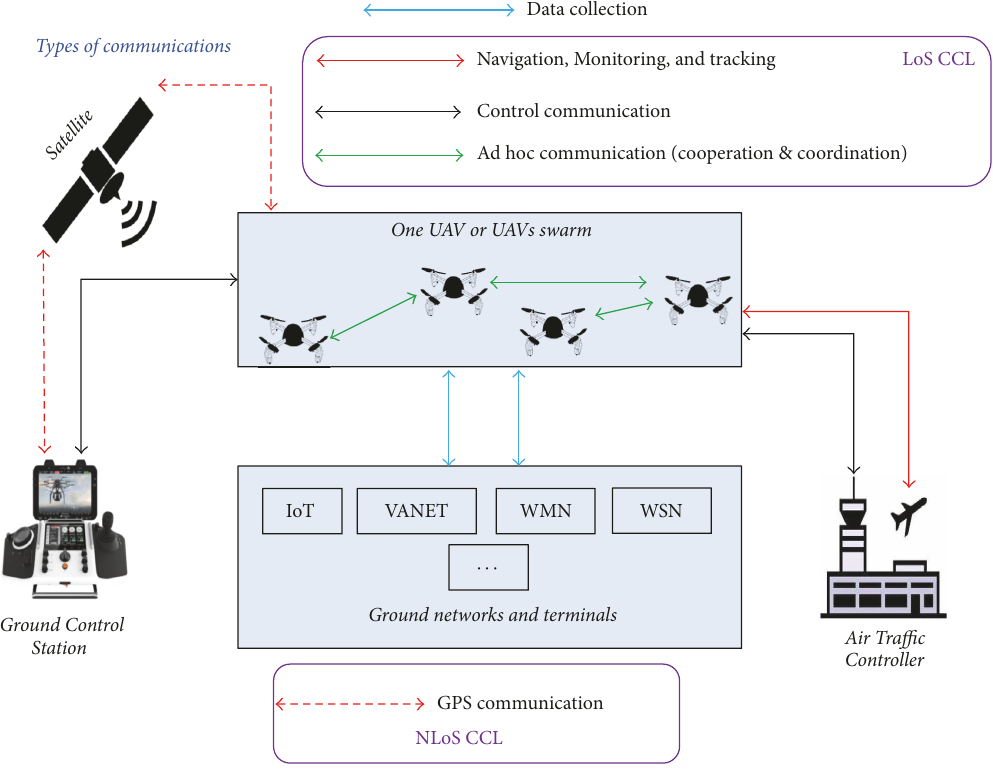
Figure 1: Communication